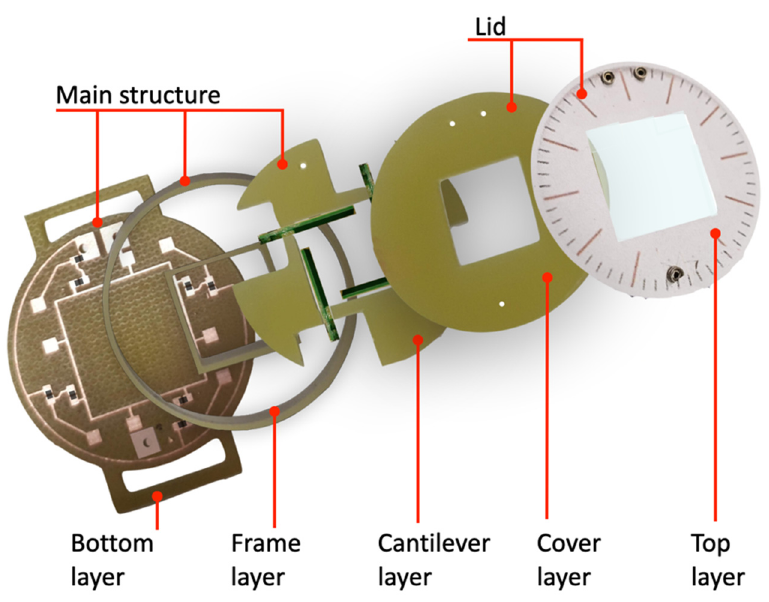
Figure 7. Images of the FR-4 layers that compose the main structure and the lid of the fabricated bi-axial multi-converter harvester prototype.